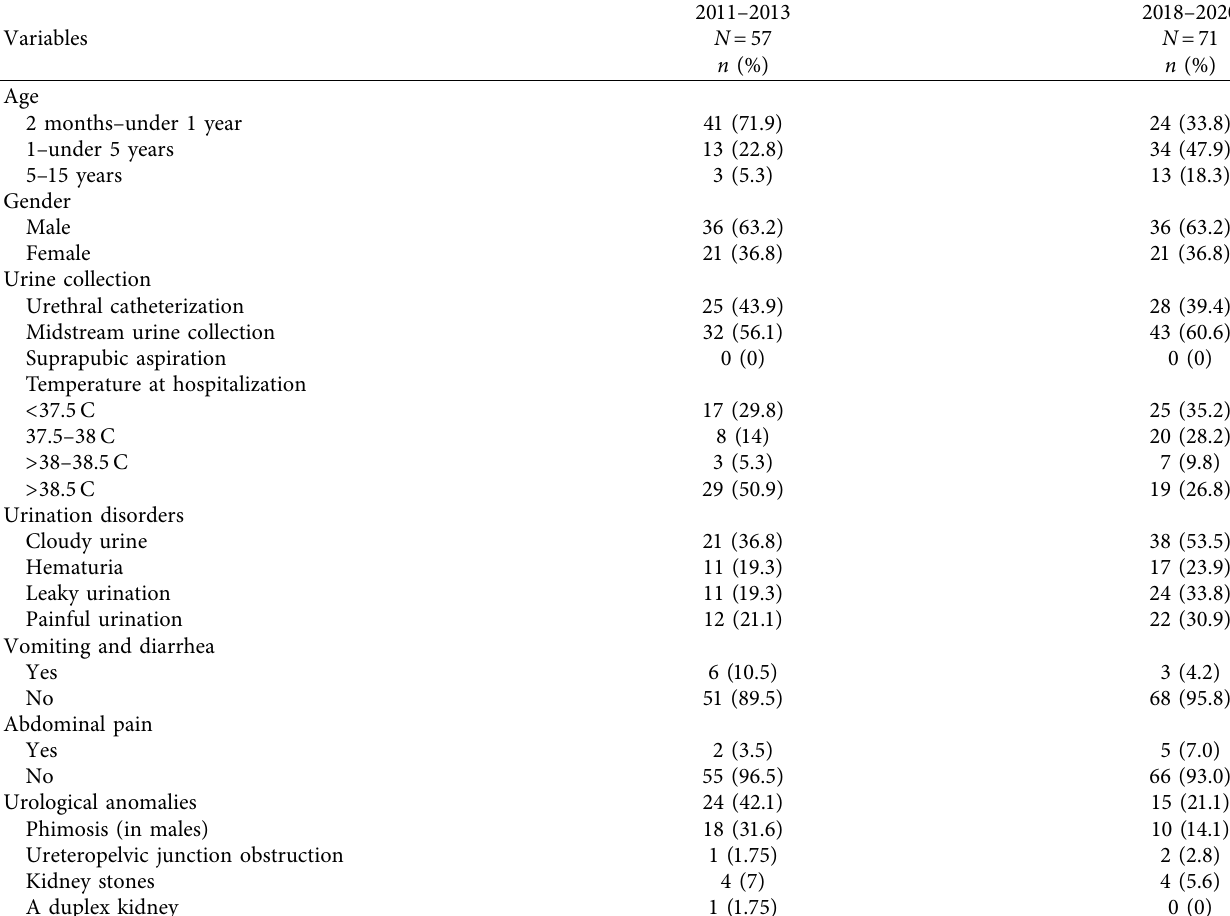
Table 1: Demographic and clinical data of the studied children with urinary tract infection caused by E. coli ( N � 128).